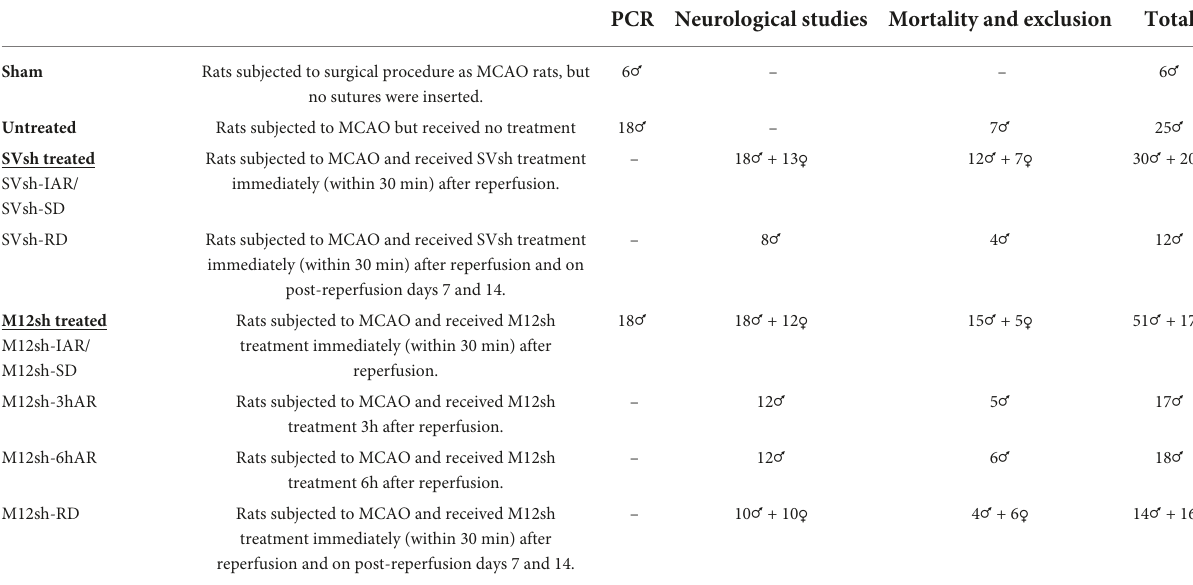
TABLE 1 Experimental groups, description, and the number of animals used for each experiment. Group name Group description Number of animals PCR Neurological studies Mortality and